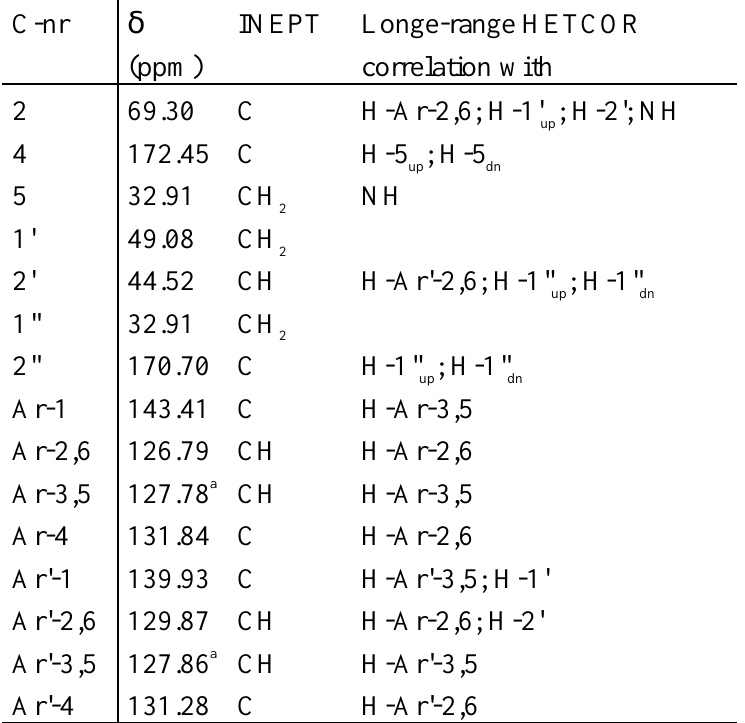
Table 2. 13 C-NMR data of ( 1